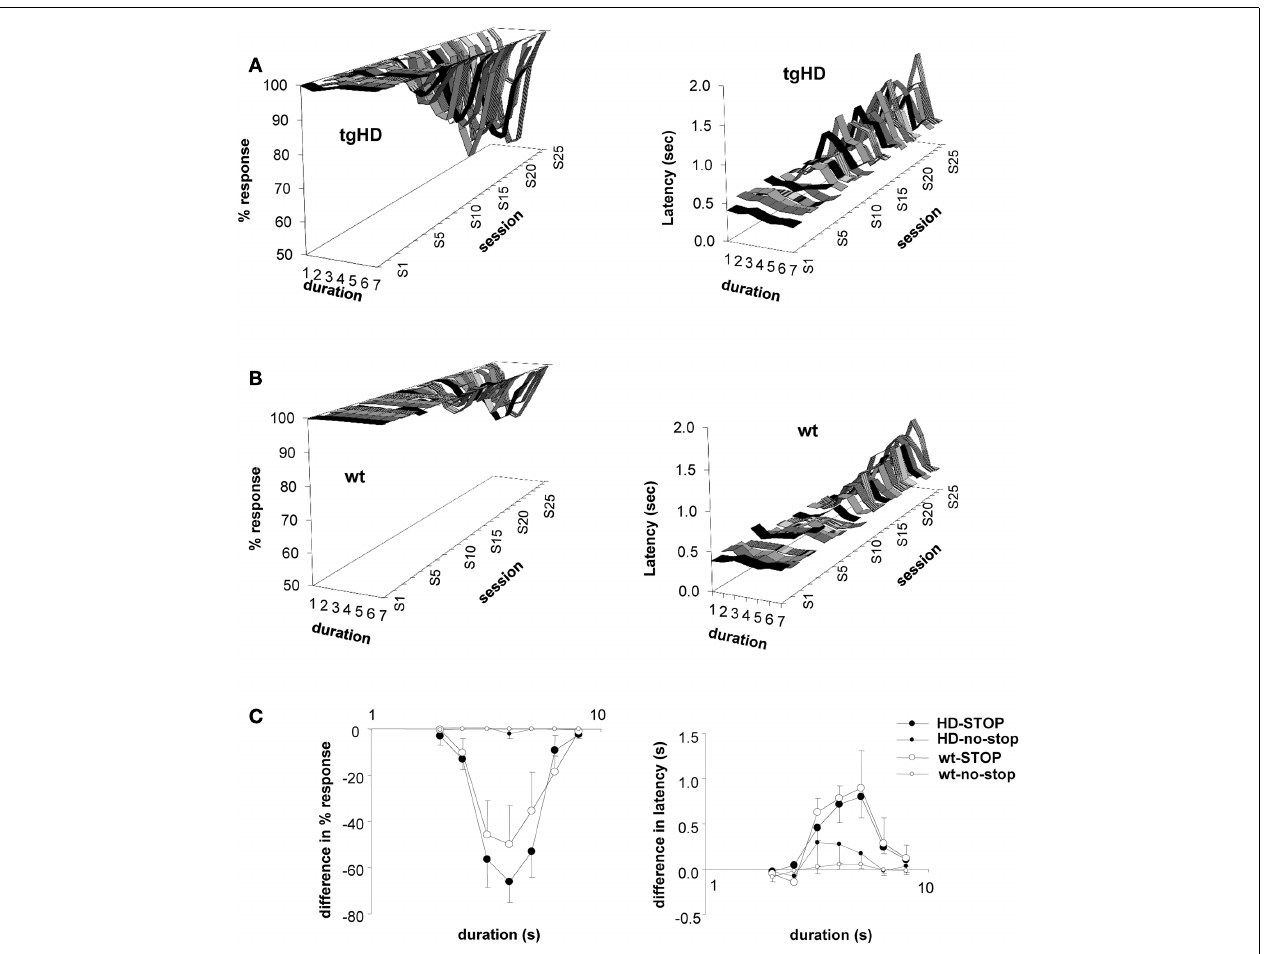
intermediate durations (with a criterion of 95%). In (C) right panel, mean ( ± SEM) difference in response latencies between the 4-months tests and (a) the last test session prior to stopping responding (95% criterion) for subgroups of animals that stopped responding or (b) the last test session for the no-stop subgroups. For both panels, data are shown as a function of both genotype and